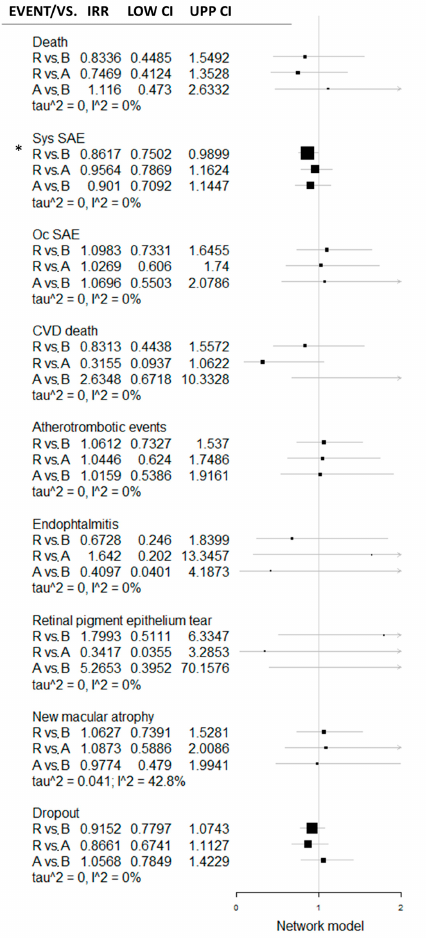
Figure 3. Forest plot with direct and indirect comparison of RBZ, BVZ and AFB in the frame of the network meta-analytic model. Systemic serious adverse event (SAE) rate differs significantly between BVZ and RBZ, whereas the other safety parameters’ di ff erence was recognized as statistically insignificant, both direct and indirect. *—significantly higher systemic SAE rate in BVZ vs. RBZ. R-ranibizumab; B-bevacizumab; A-aflibercept; CVD-cardiovascular diseases, Oc SAE–ocular serious adverse events; Sys SAE-systemic serious adverse events; tau2-between-study variance; I 2 –percentage of variance related to between-study heterogenicity; LOW CI–lower limit of confidence interval; UPP CI–upper limit of confidence interval; IRR–incidence rate ratio;